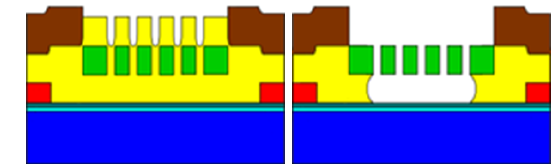
Figure 5. Cross section of the detector chip before (left) and after (right) wet chemical etching of silicon dioxide (Kallis et al., 2014).